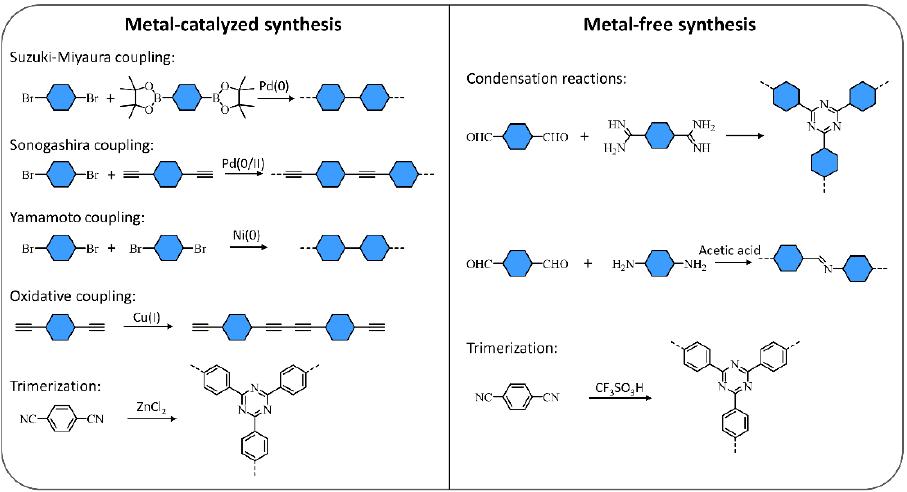
Figure 2. Metal-catalyzed reactions and metal-free methods that have been used to synthesize organic photocatalysts for solar fuels production [23–25,8].